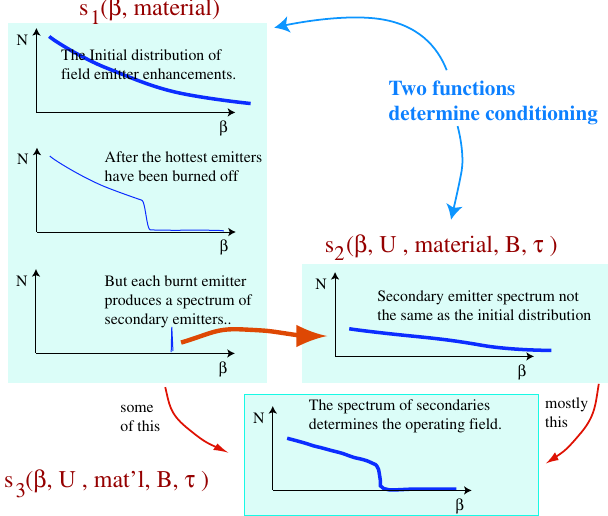
FIG. 2. (Color) Cavity surface damage, parametrized by the spectrum of enhancement factors, can be described in terms of (cid:4) (cid:1) (cid:7) , which describes a new surface, s three functions: s 1 which describes the damage produced during a breakdown event, (cid:4) (cid:1) (cid:7) , which describes the damage in a well conditioned and s 3